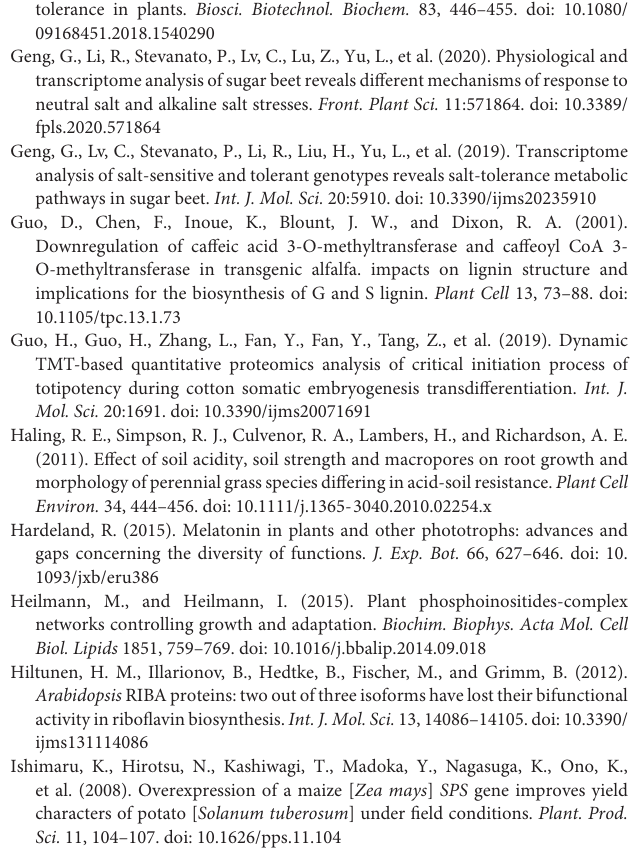
different pH conditions. Supplementary Table 1 | List of the QRT-PCR primer. Supplementary Table 2 | Peptide information identified by mass spectrometry in leaves. Supplementary Table 3 | Peptide information identified by mass spectrometry in roots. Supplementary Table 4 | Protein information identified by mass spectrometry in leaves and